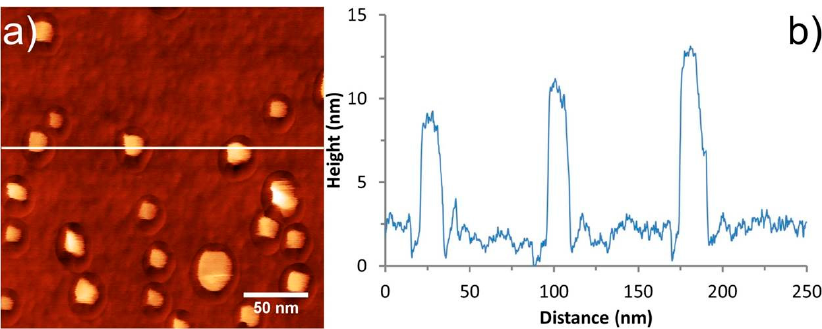
Figure 6. AFM image of gold nanoparticles in PFT mode using probe CNT1, with corresponding Figure 6. ( a ) AFM image of gold nanoparticles in PFT mode using probe CNT1, with ( b ) corresponding cross sections. The height or color scale for the image is 20 nm. cross sections. The height or color scale for the image is 20 nm.